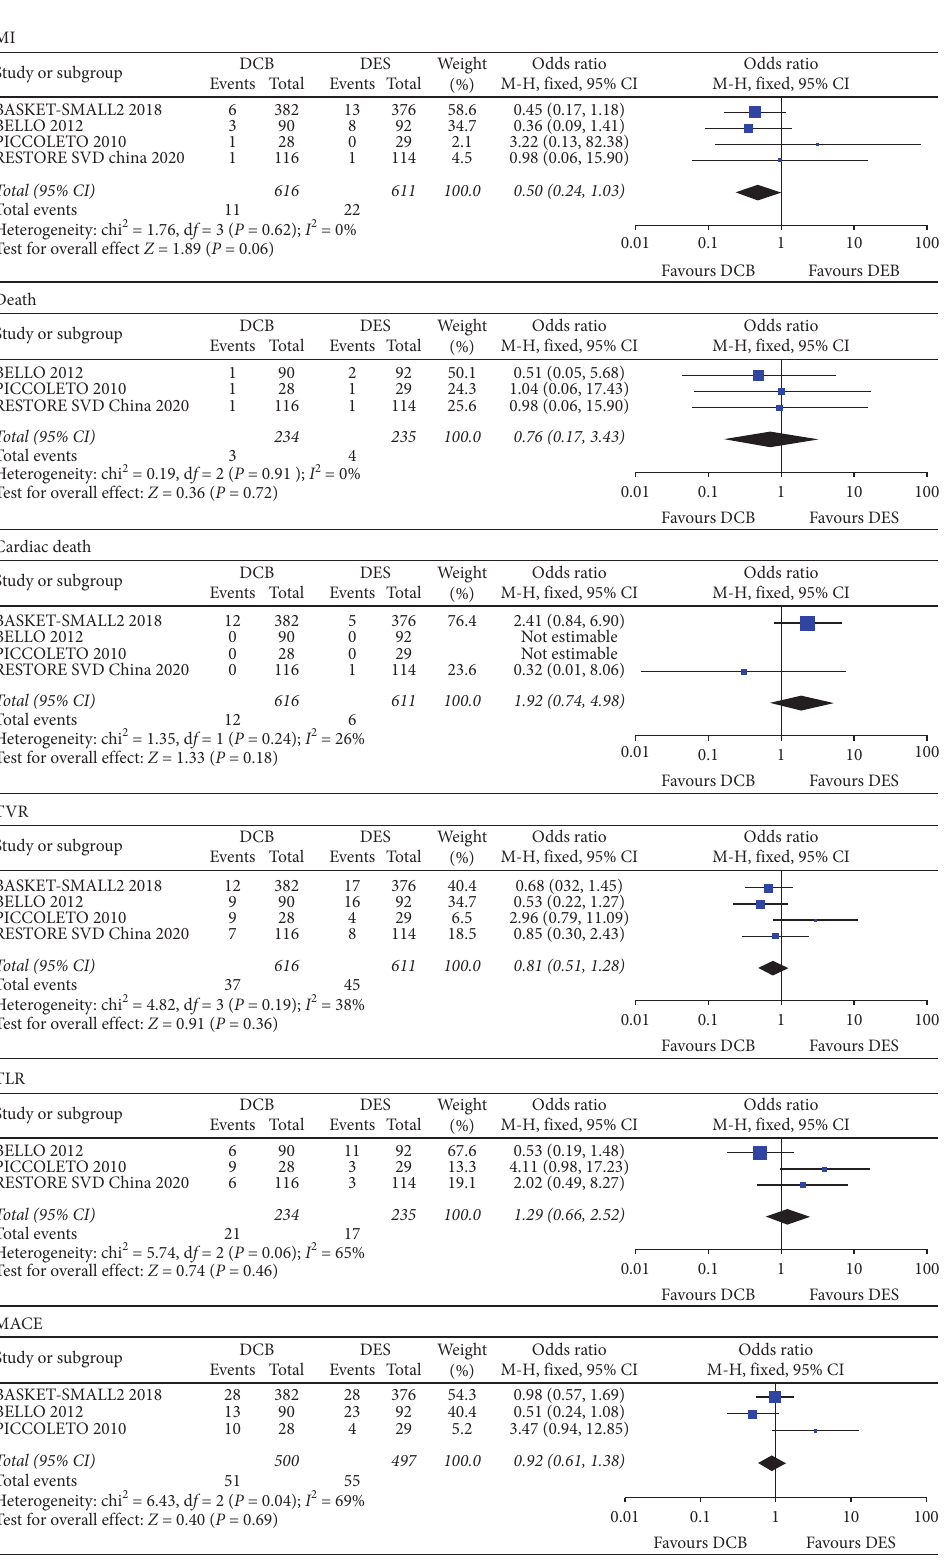
Figure 4: Forest plots comparing DCB with DES in MI, death, cardiac death, TVR, TLR, and MACE. DCB, drug-coated balloon; DES, drug- eluting stent; MACE, major adverse cardiac events; MI, myocardial infarction; TLR, target lesion revascularization; TVR, target vessel